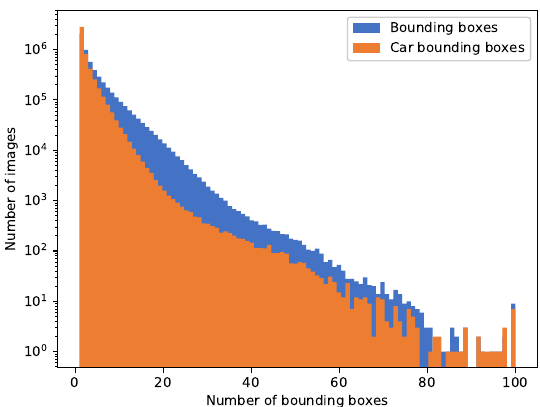
Figure 5. A number of images with respect to bounding boxes per image in the joined LSUN car dataset and the Stanford car dataset (without pruning). It can be seen clearly that in many images there are not just cars, but also many other objects (that represent noise for GAN training). The scale of the y-axis is logarithmic in order to present the distribution of data better.